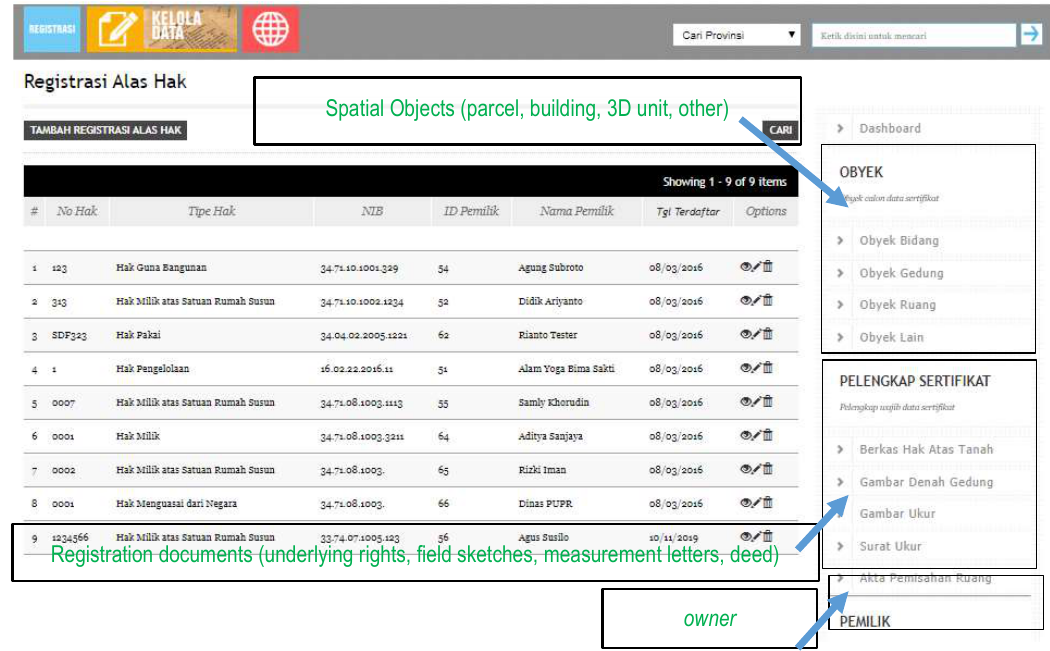
Figure 12. Managing spatial and non-spatial data related to objects (2D parcel, 3D building, 3D unit, other objects), registration documents (underlying rights, field sketches, measurement letters, separation deed), and owner information can be done through the data management menu.